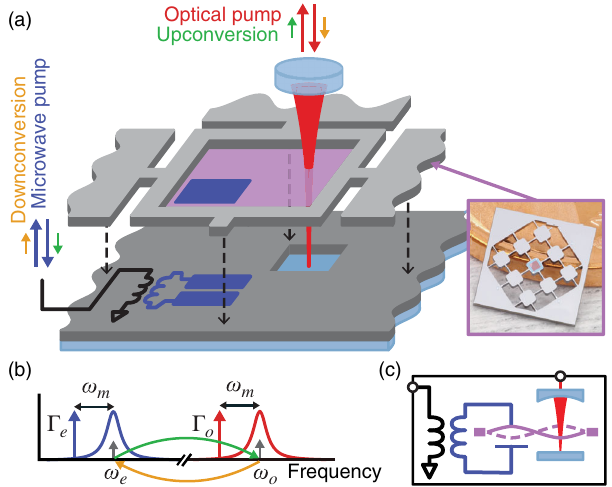
FIG. 1. Transducer design and operation. (a) Illustration of transducer (not to scale). A vibrational mode of a silicon nitride membrane (purple) couples to a microwave-frequency inductor- capacitor circuit (dark blue) and a Fabry-Perot optical cavity mode (red) confined between two high-reflectivity mirrors (light blue). The membrane, microwave circuit, and one of the cavity mirrors are integrated into a stack of three silicon chips. Micro- wave and optical pumps (blue and red arrows) enhance the electromechanical and optomechanical interactions, respectively, and allow upconversion of a microwave signal (green arrow) or downconversion of an optical signal (orange arrow). The inset shows the membrane (false-colored purple) suspended on a phononically engineered silicon substrate (gray). (b) Transducer frequency scales. The microwave and optical pumps are red detuned by the mechanical frequency ω from microwave and m optical resonances ω and ω , respectively. The electromechani- e o cal and optomechanical damping rates Γ and Γ scale with the e o corresponding pump powers. (c) Simplified diagram in which the transducer is represented as a two-port